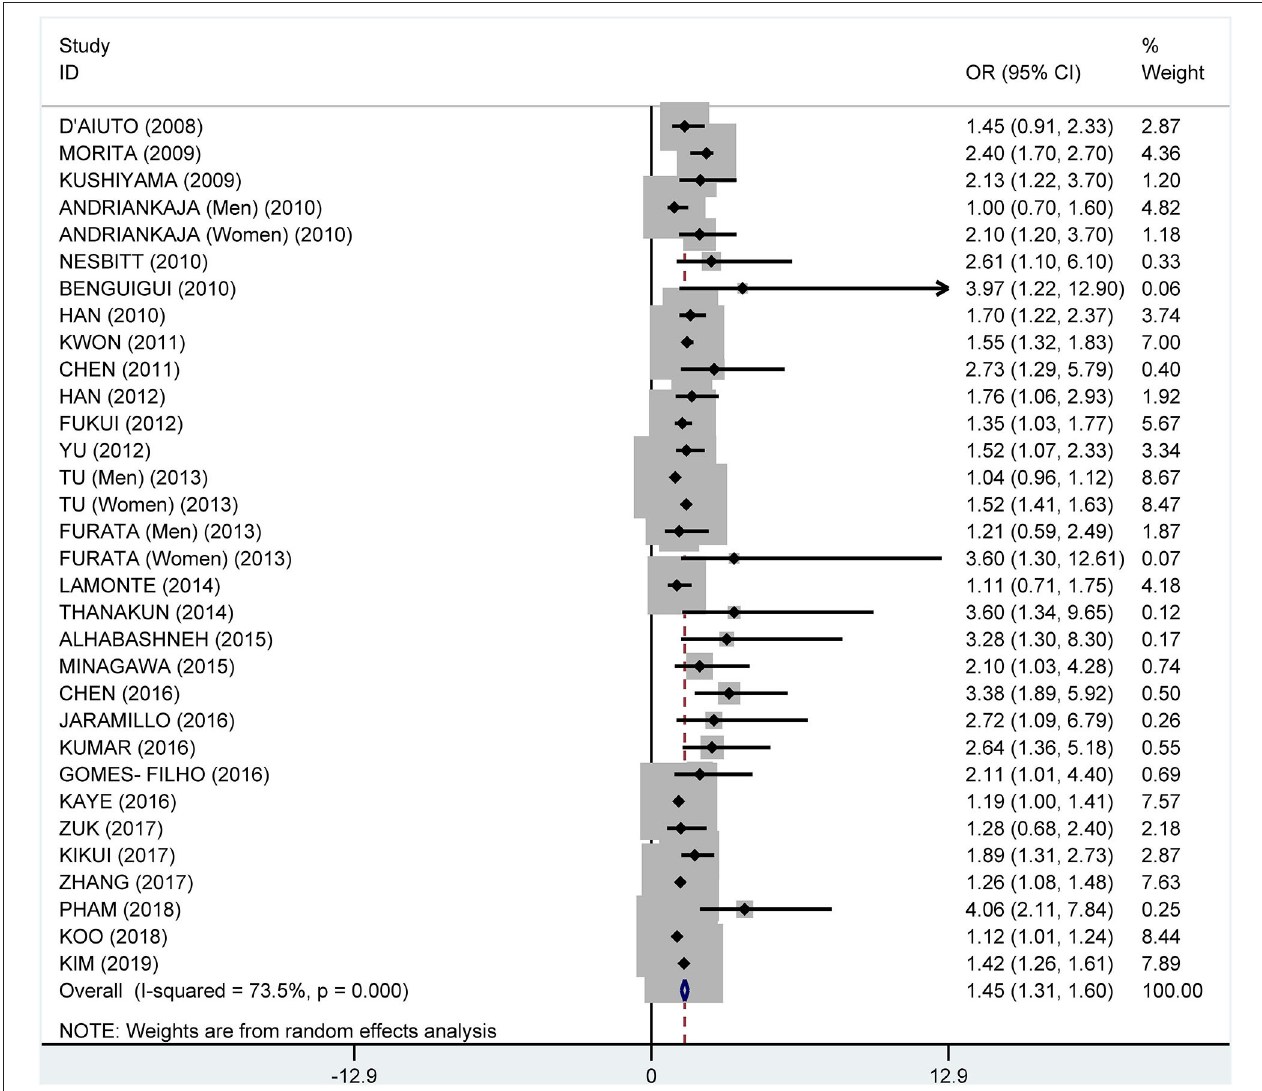
FIGURE 4 | Pooled adjusted odds ratios of the association between periodontitis and metabolic syndrome.